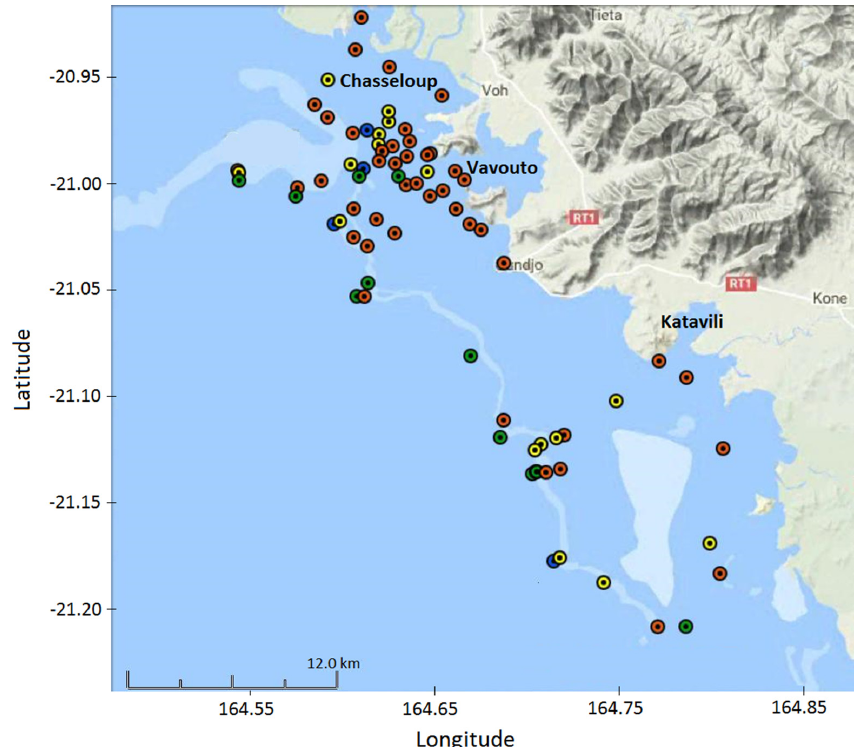
Figure 1 . Visited stations at the Voh ‐ Koné ‐ Pouembout (VKP) lagoon (Google Maps Terrain overlay). Points colours correspond to bathymetry, i.e.,